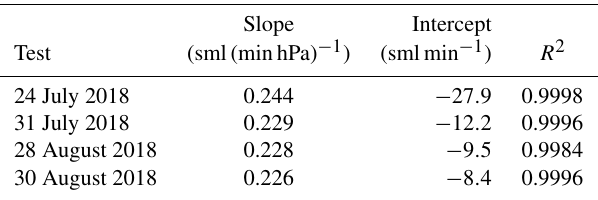
Table 4. Coefficients and R 2 obtained fitting a straight line to the test data shown in Fig.